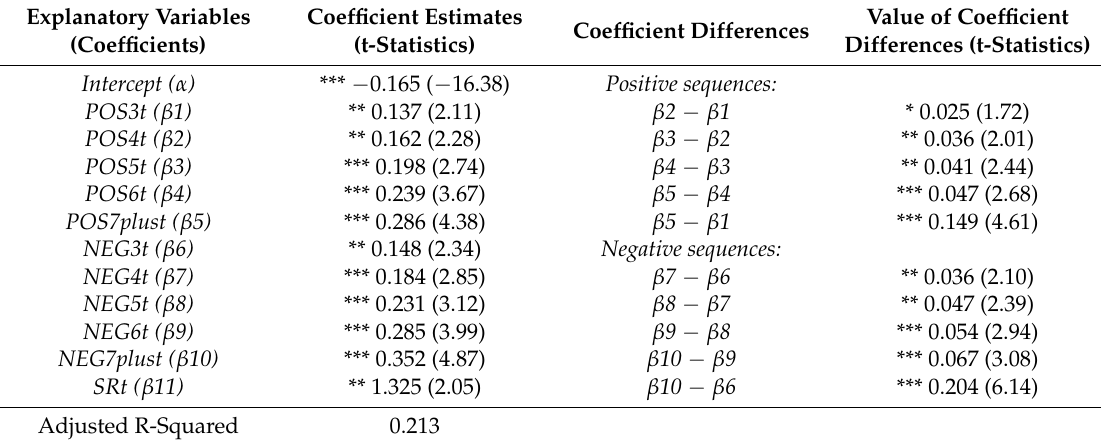
Table 2. Regression analysis (regression (2)): Return sequence effect on stock trading volumes (Dependent variable—ABVOL).